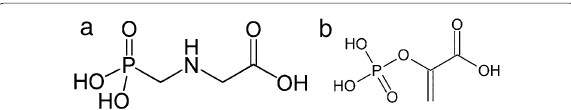
Fig. 1 Molecular structures of a glyphosate and b phosphoenolpyru- vic